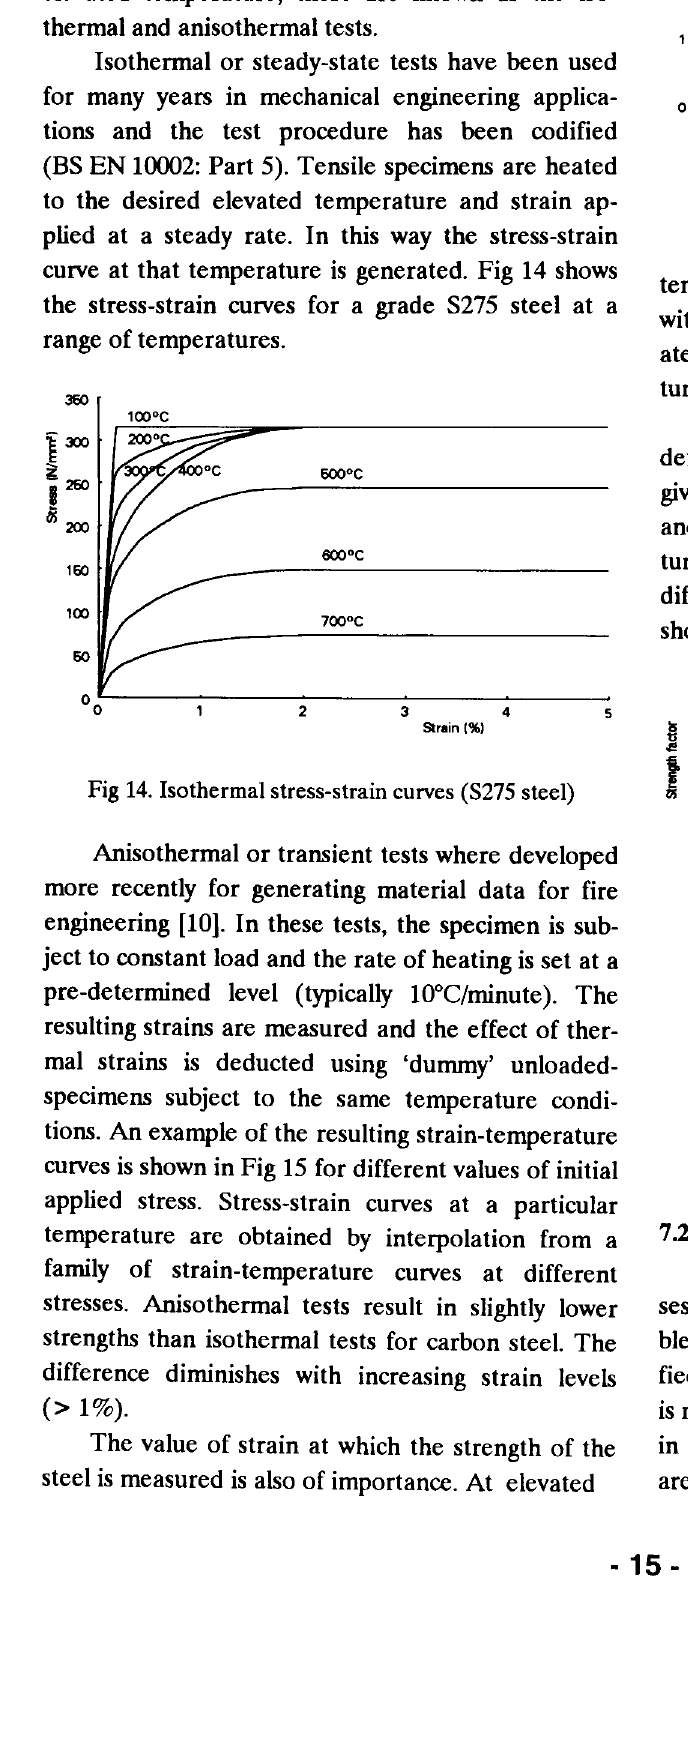
Fig 15. Anisothermal strain-temperature curves (S275 steel) temperatures there is a gradual increase of strength with increasing strain. The selection of the appropri ate strain limit (which reflects the behaviour of struc tural members in fire) is therefore important. Values of elevated temperature 'yield stress' are defined in terms of a strength reduction factor. This gives the strength of steel at a particular temperature and mechanical strain as a ratio of the room tempera ture yield strength. The strength reduction factors at different values of strain for grade S275 steel are shown in Fig 16.